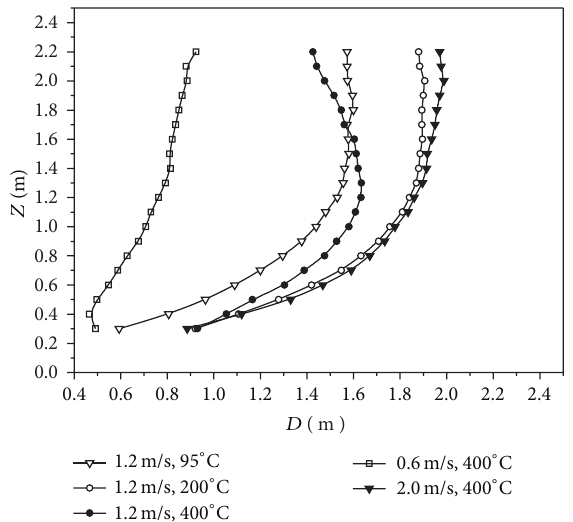
Figure 10: Cross-section diameter of high-temperature annular buoyant jets varying along with the height with different initial